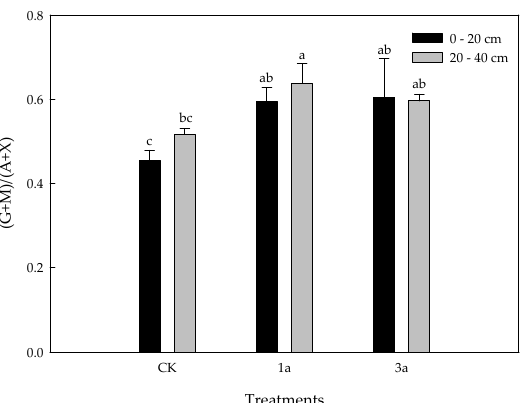
Figure 2. The effects of treatment on the ratio of (G + M)/(A + X). G means galactose; for the ratio >2, neutral sugars come from microorganisms; for the ratio <0.5, neutral sugars come from plants. CK: control; 1a: shoots returned for 1 year; 3a: shoots returned for 3 years. Different lowercase letters in the same figure indicate significant differences at the 0.05 level.